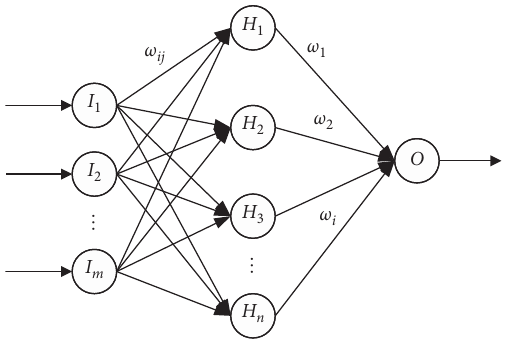
Figure 1: The structure of